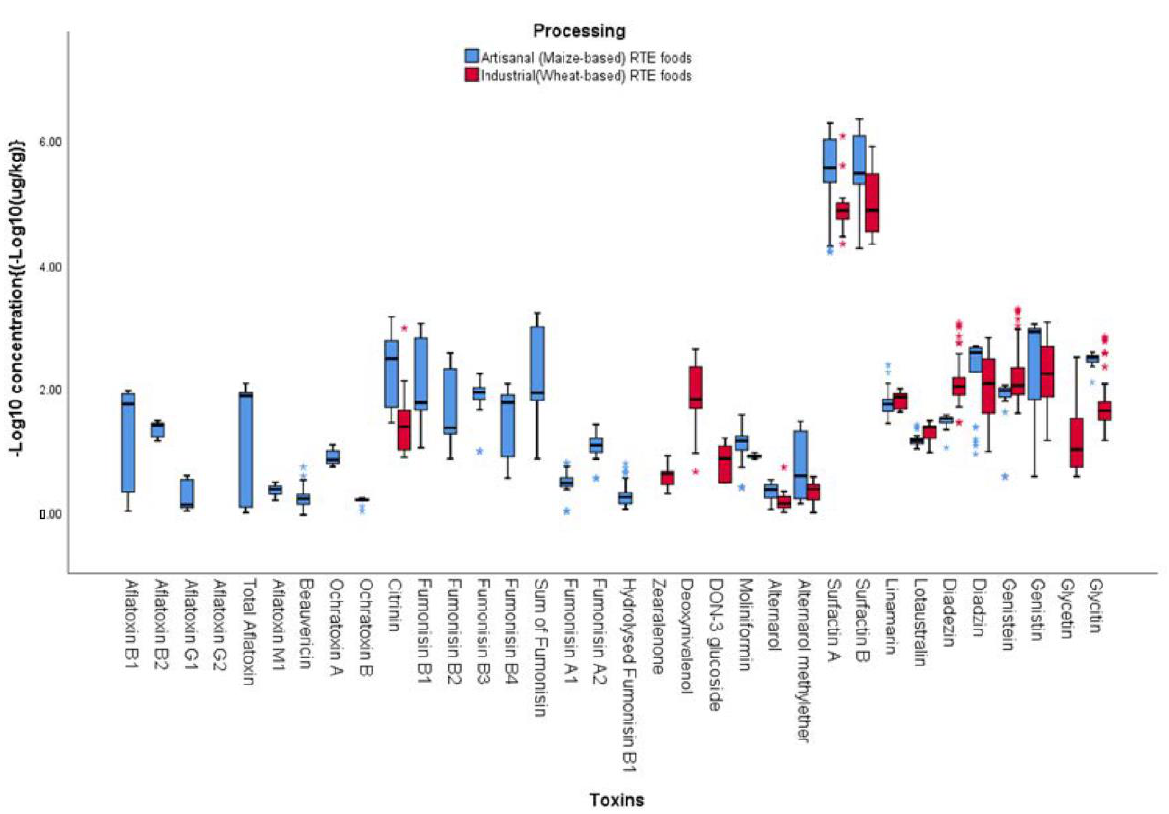
Figure 5. Variation in biotoxins in artisanal and industrial ready-to-eat foods vended in Lagos State, Nigeria. *: outlier data. Table 3. Regulated mycotoxins, phytoestrogens, phytotoxins, and bacterial metabolites in maize-